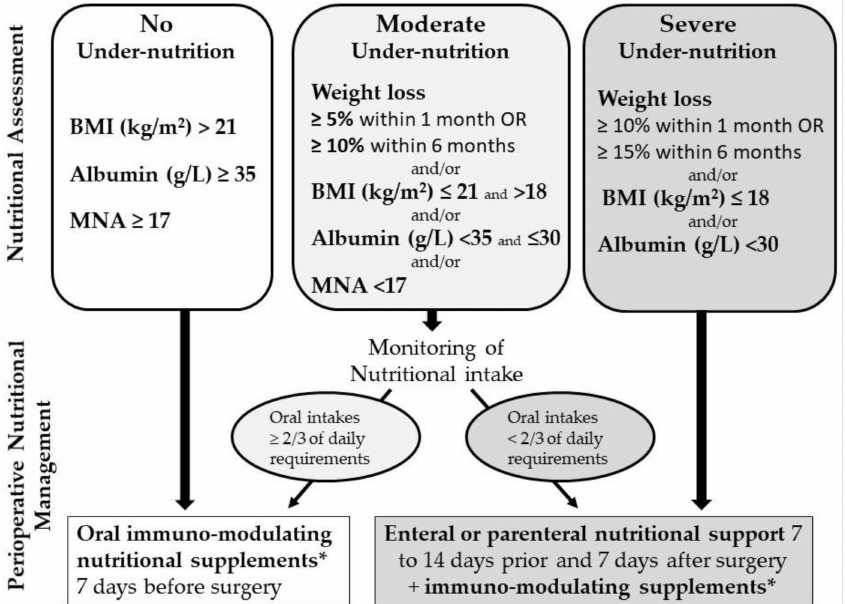
Figure 1. Perioperative undernutrition screening and management for CRC surgery. Proposed algo- rithm during the ANC study, based on guidelines from ESPEN [21,23,24] and French SFAR/SFNEP guidelines [22]. * Arginine, omega-3 fatty acids, and nucleotides: 3 supplements/day 7 days before surgery (1000 Kcal/d) and 7 days after surgery for undernourished patients (1500